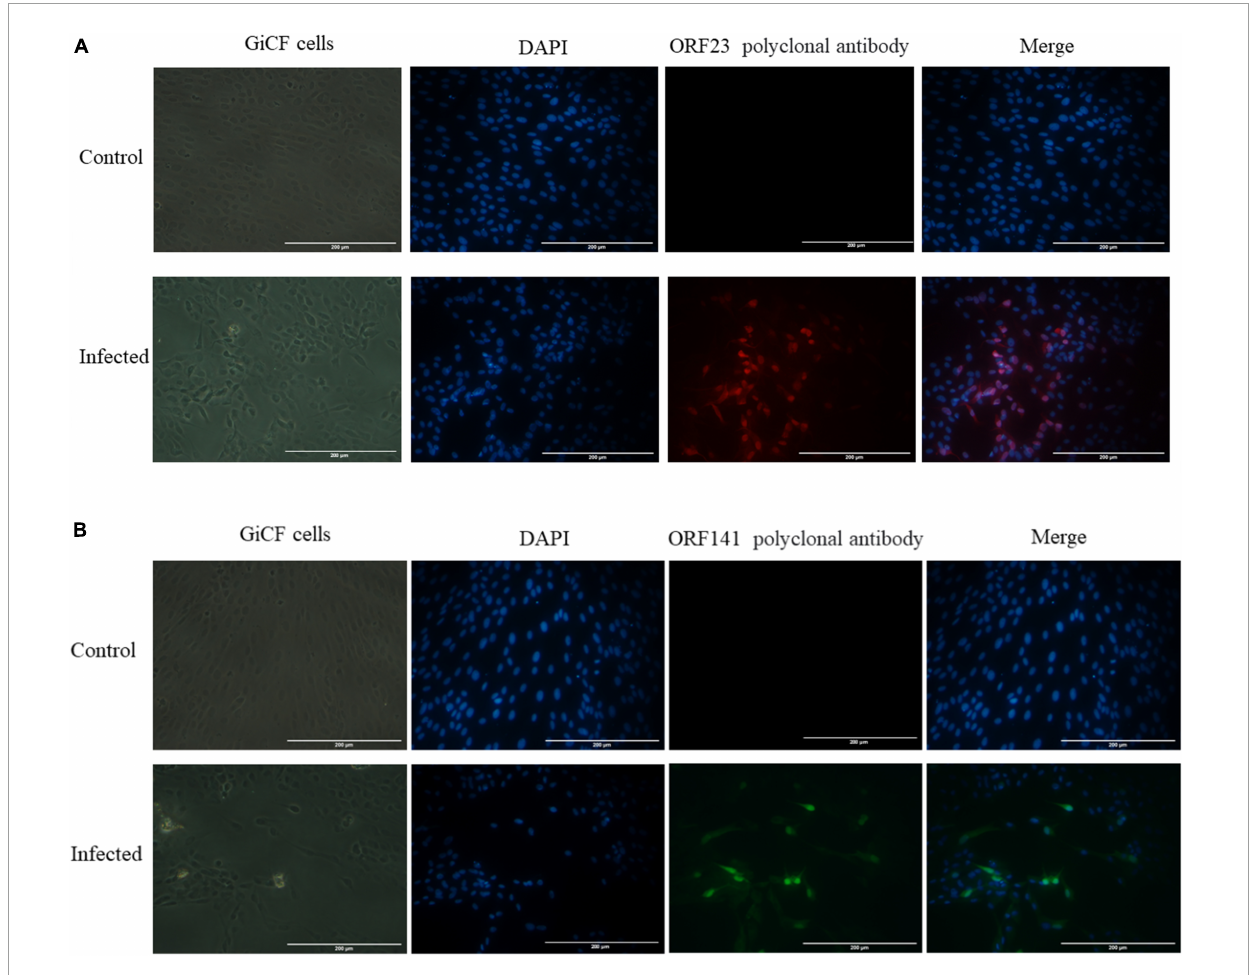
FIGURE2 Indirect immunofluorescence detection of ORF23 and ORF141 in GICF cells infected with CyHV-2 (MOI = 1). (A,B) The control group was uninfected GICF cells, while the infected group was the GICF cells infected with CyHV-2 (MOI = 1). The nuclei were stained with DAPI. (A) ORF23 pAb was labeled in red by secondary antibody coupled with red fluorescent substrates; (B) ORF141 pAb was labeled in green by secondary antibody coupled with green fluorescent substrates. Scale bars indicate 200 µ m (A,B) .